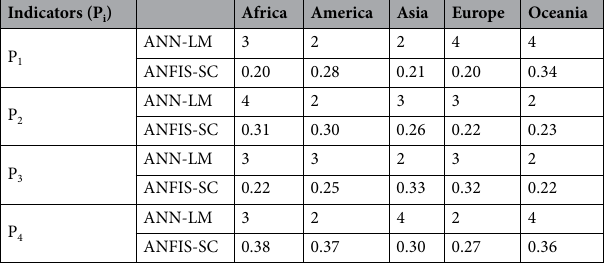
Table 4. The activation functions of the output nodes were linear for all the continents. The activation functions of the hidden nodes of the ANN-LM models for the P1 through P4 indicators were respectively the tangent